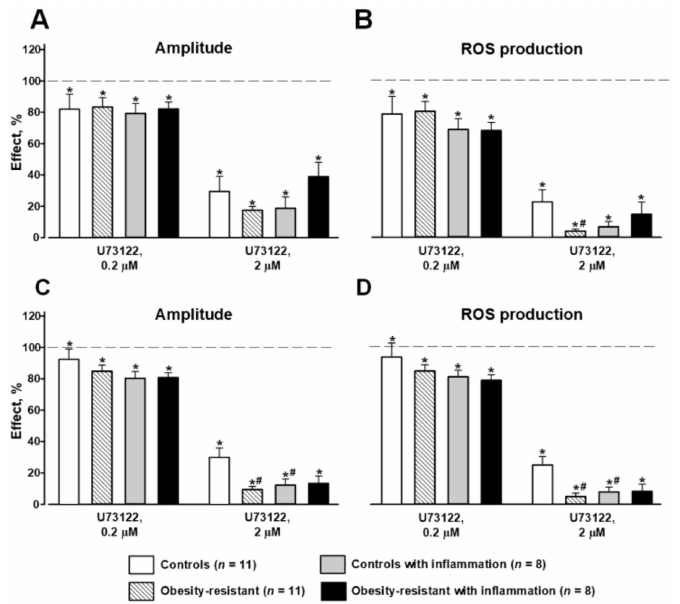
Figure 3. Effects of U73122, PLC inhibitor, on FPR-mediated respiratory response in murine bone marrow granulocytes. Amplitude ( A , C ) and reactive oxygen species (ROS) production ( B , D ) in responses to 1 µ M fMLF ( A , B ) and 1 µ M WKYMVM ( C , D ). Data are presented as mean ± SEM. Significant differences are indicated as follows: * p < 0.05 between parameters of inhibitor-treated and intact cells within the same group by Mann–Whitney rank sum test; and # p < 0.05 compared to controls by ANOVA on